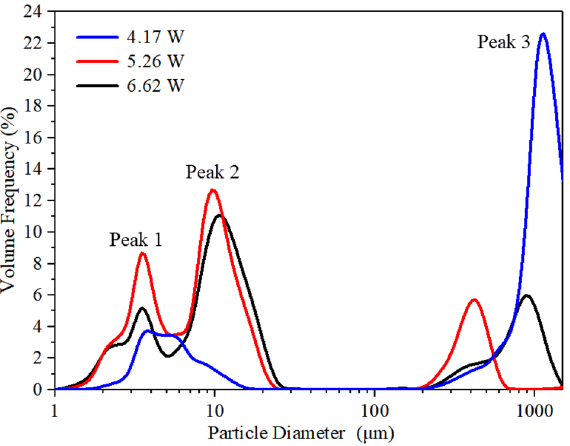
Figure 6. The aerosol size distribution of salbutamol solution atomized under different input powers.